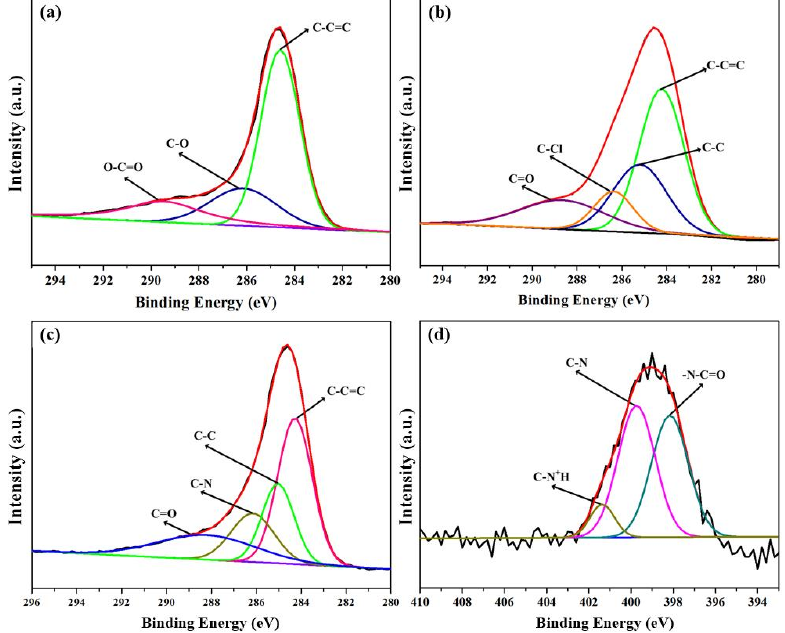
Figure 5. The C 1s spectrum of MWCNTs-COOH ( a ), MWCNTs-COCl ( b ) and MWCNTs-APTES ( c ) and N 1s spectrum of MWCNTs-APTES ( d ).